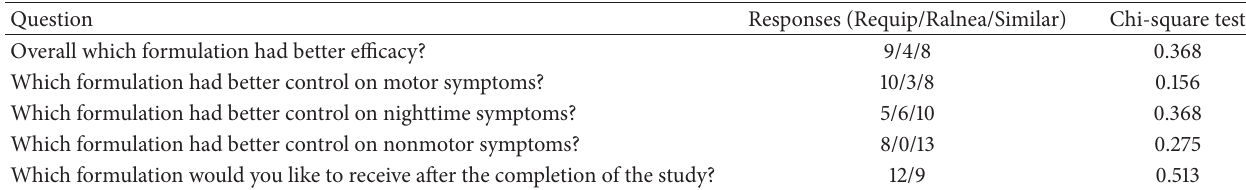
Table 3: Results of the poststudy patient